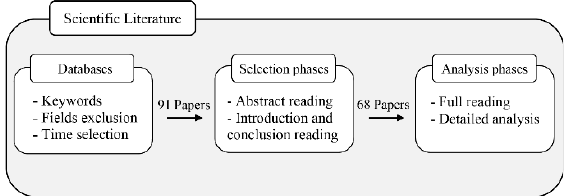
Figure 1. Scientific literature review